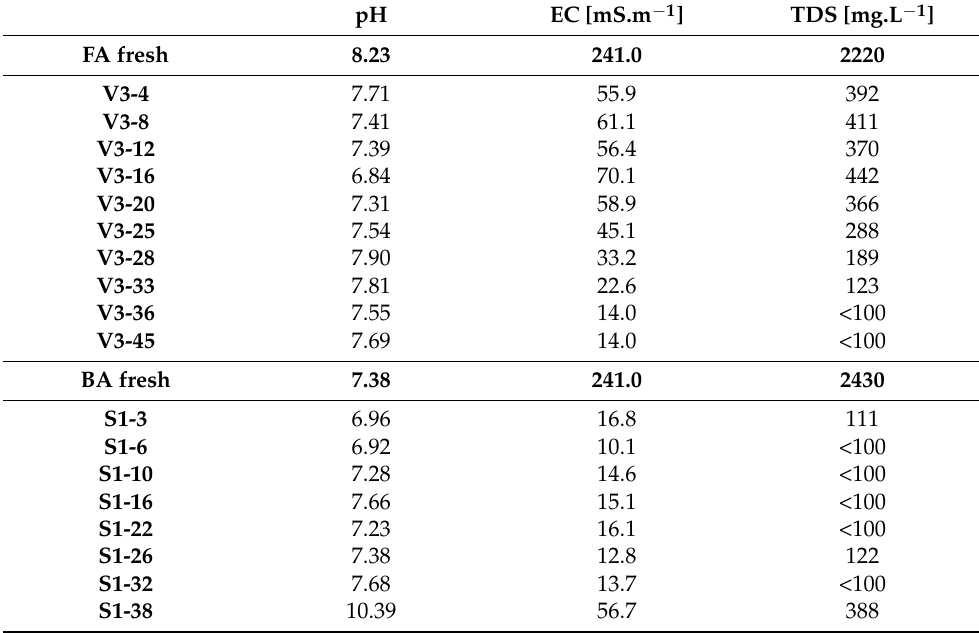
Table 3. Values of pH, Electrical Conductivity (EC) and Total Dissolved Solids (TDS) for Fresh FA, Bottom Ash BA and Samples from Core Boreholes V3 and S1; measurement errors were below